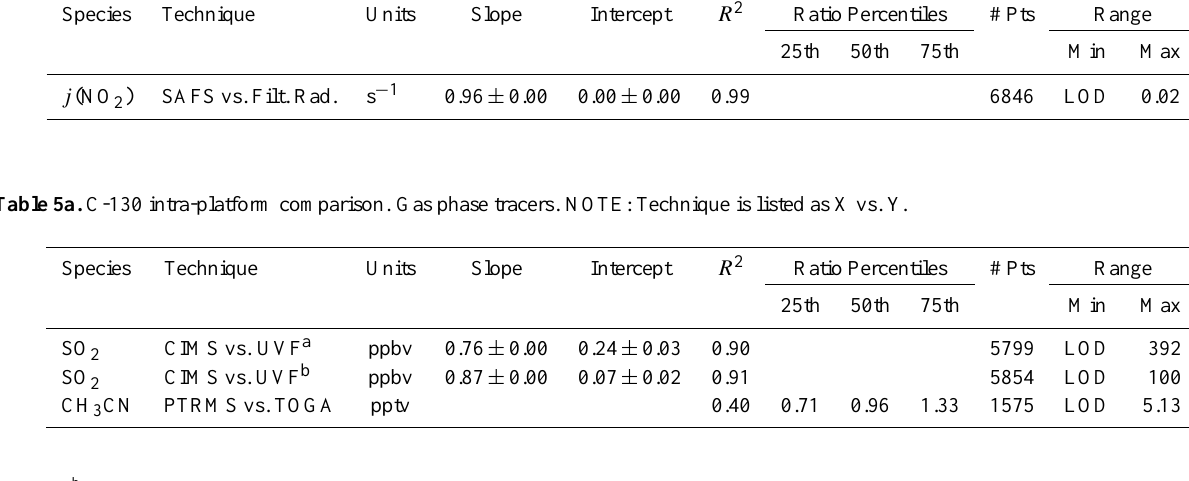
Table 4c. DC-8 intra-platform comparison. j -values. NOTE: Technique is listed as X vs. Y. Species